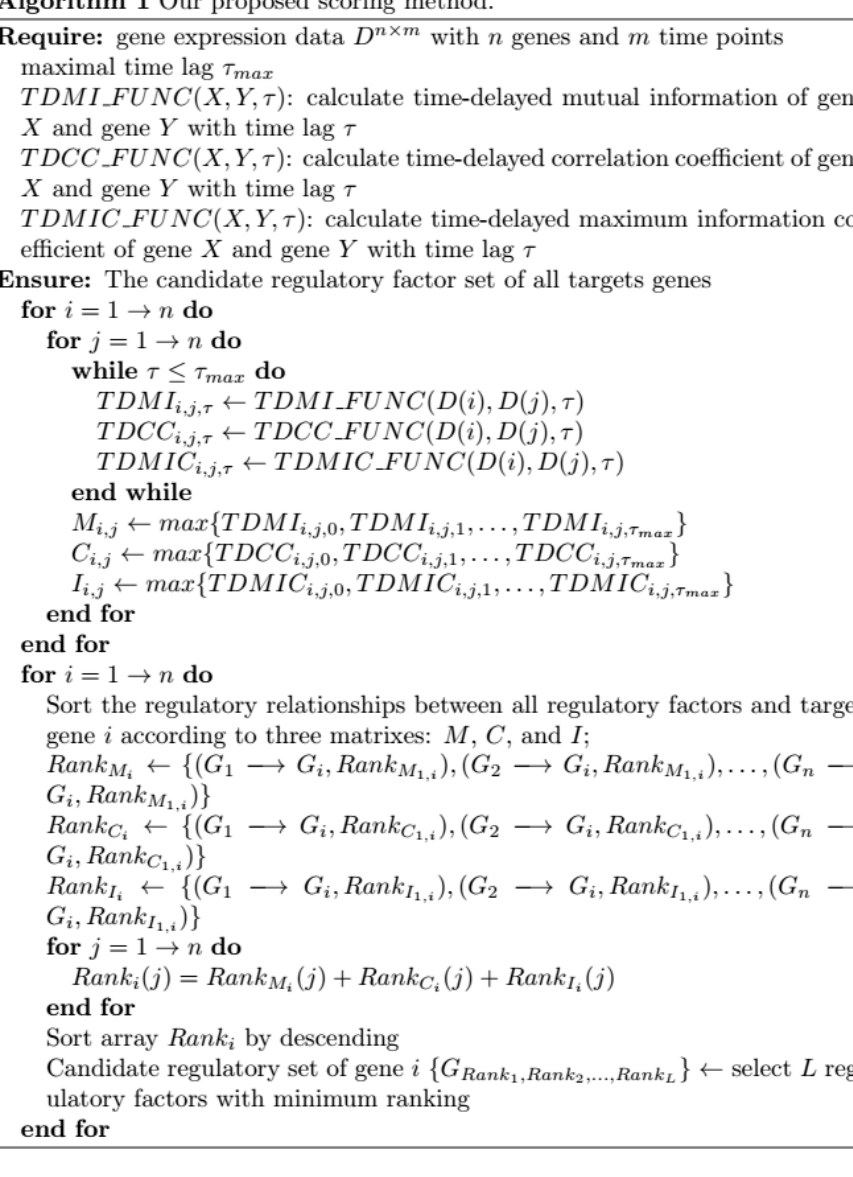
Figure 15. The pseudo code of our proposed scoring method.